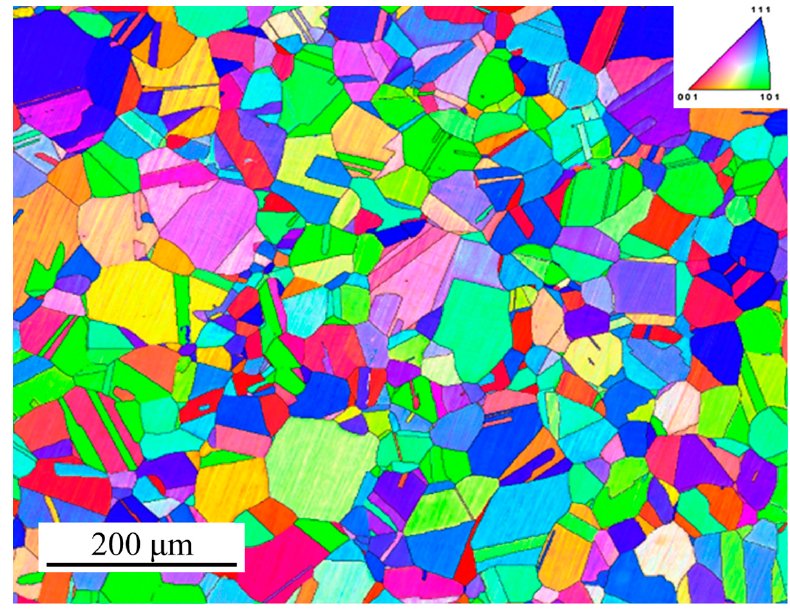
Figure 4. IPF of 304 austenitic stainless steel base metal.